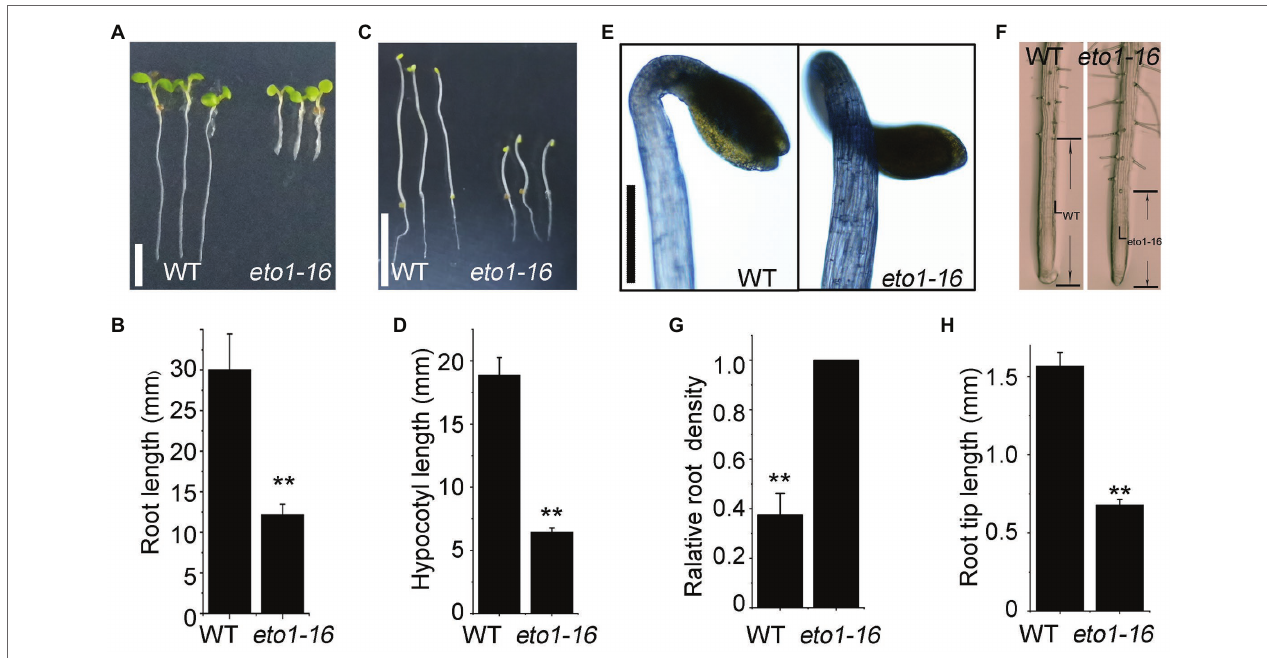
FIGURE 1 | Root and hypocotyl phenotypes of eto1-16 . (A) Root phenotypes of wild-type (WT) and eto1-16 grown under a 16/8 h light/dark period. Scale bar = 10 mm. (B) Statistical analysis of the root length of plants in (A) . (C) Hypocotyl phenotypes of WT and eto1-16 grown in the dark. Scale bar = 10 mm. (D) Statistical analysis of the hypocotyl length of plants in (B) . (E) The apical hook phenotype of eto1-16 . Scale bar = 1 mm. (F) Root tip phenotypes of WT and eto1-16 . The relative root density (G) and the root tip length (H) of plants in (D) . Statistical analysis was performed using a two-tailed Student’s t -test (** p < 0.01). At least 50 plants were used in root and hypocotyl phenotype